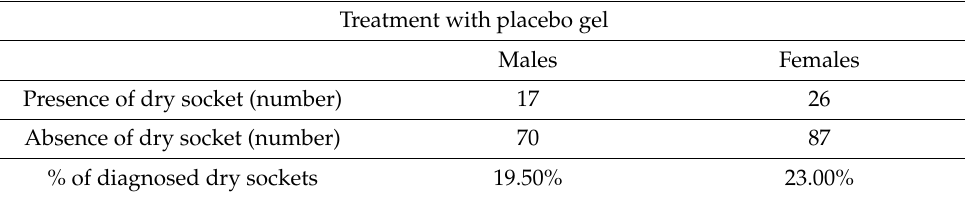
Table 3. Cont. Treatment with Ozone in the Form of Sunflower Oil-Based Gel (Ozosan)